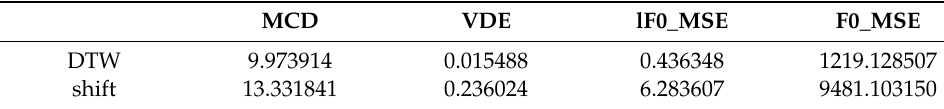
Table 2. Objective measures for the typical TTS system.